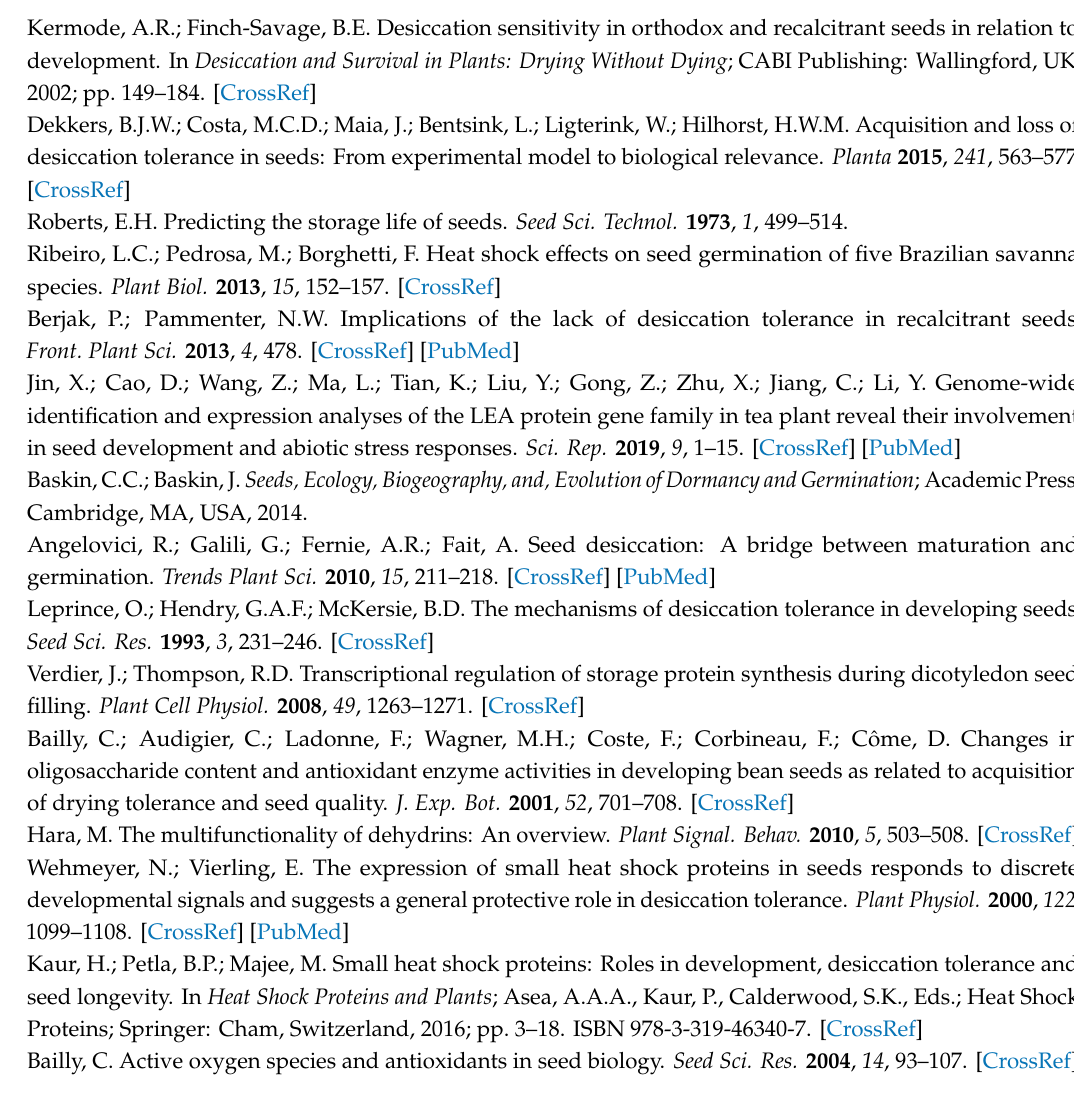
Figure S1: Histochemical detection of ROS, Figure S2: Redox status of MsrB2, Table S1: Correlation coe ffi